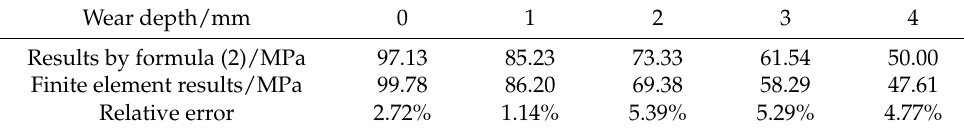
Table 1. Comparison of results by Formula (2) and finite element method for casing body.